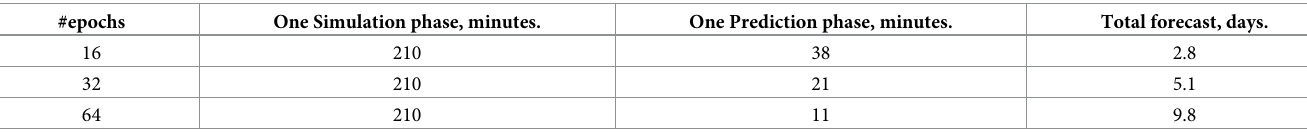
Table 5. Maximum elapsed times vs. # epochs to forecast L2C2 from start to 50% capacity. #epochs One Simulation phase, minutes. One Prediction phase, minutes. Total forecast,